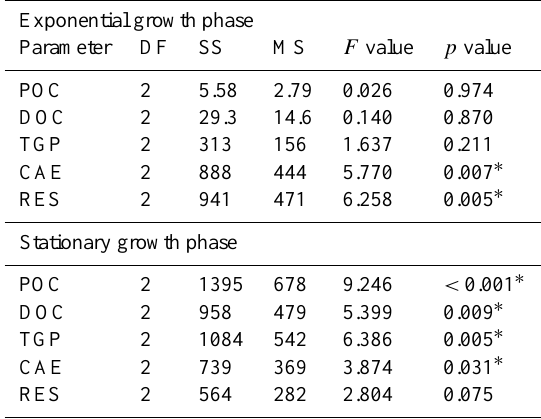
Table 2. Statistical comparison using one-way ANOVA on ranks. Tukey’s post hoc test of statistically significant differences ( ∗ ) can be found in Table 3 (exponential growth phase) and 4 (stationary growth phase).